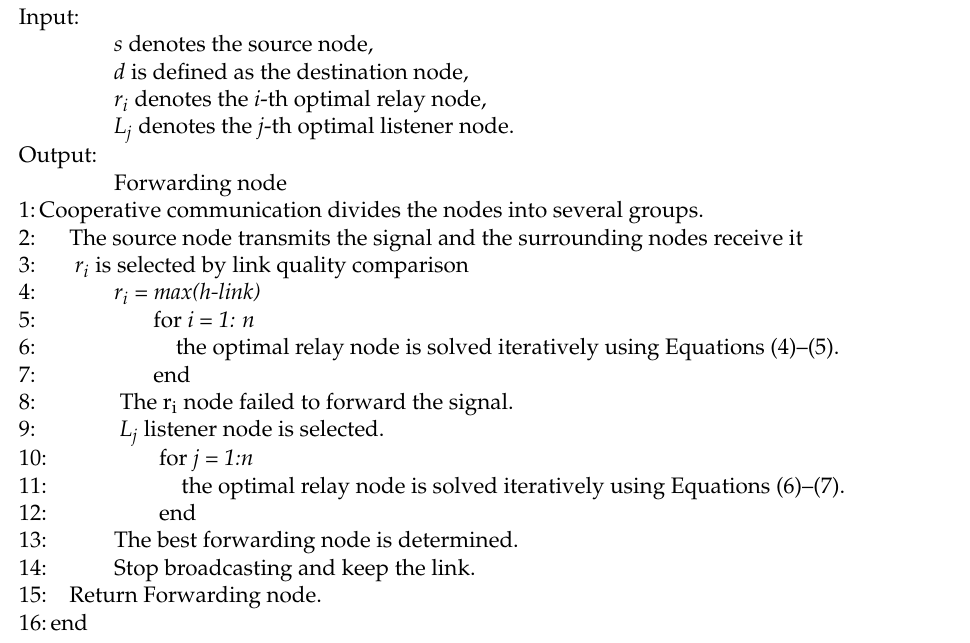
Table 2. Improved algorithms of